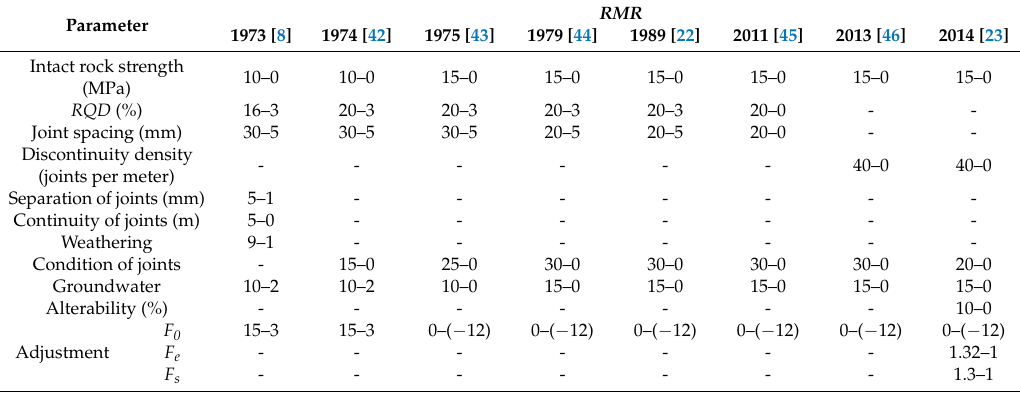
Table 2. Characterization criteria in different versions of the rock-mass rating (RMR)